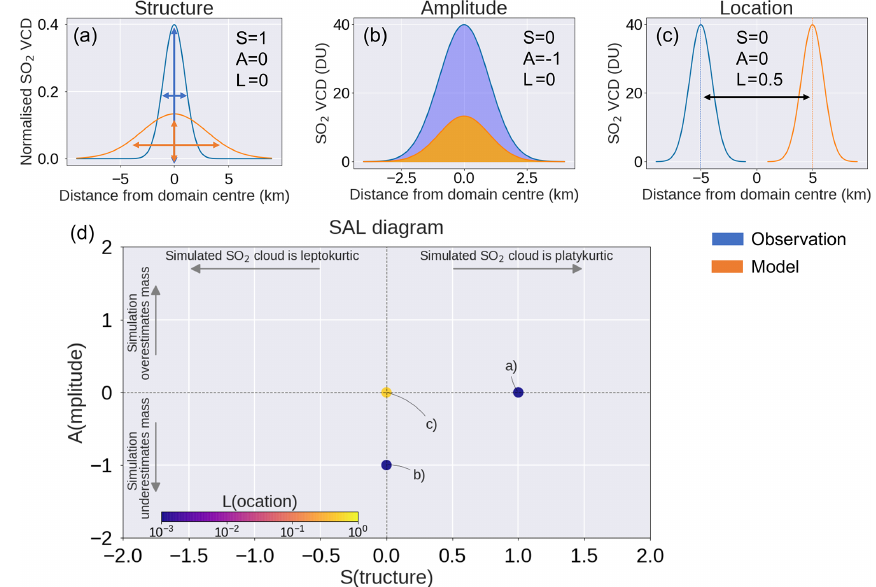
Figure 5. Schematic overview of the SAL score and its interpretation, using two cross sections of idealised Gaussian-shaped SO 2 clouds. Each panel shows the impact of an individual component of the SAL score: (a) structure, (b) amplitude and (c) location (only the L 1 part). A negative S score indicates that the simulated SO 2 clouds are too narrow or have peak SO 2 VCD values that are too high when compared to the observed cloud (leptokurtic). When the simulated SO 2 clouds are too wide spread or have peak SO 2 VCD values that are too low, this is indicated by a positive S score (platykurtic). Panel (d) shows an example of the SAL score diagram with the scores of the three cases in panels (a) – (c) included. The horizontal axis represents the S score, the vertical axis represents the A score and the colour of each point represents the L score. When the simulation and observations compare perfectly, the score of each of the components is 0. The simulation and observations compare best when all the points are near the origin and have the dark purple